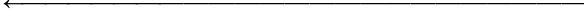
Fig. 2. a Unfiltered ground magnetometer H-component data from Nordli, Faroes and Wick compared with SABRE east-west velocity component data (positive east) averaged over a small region of the field of view, 64.6 ° to 64.8 ° N and 6 ° to 8 ° E. Dashed lines delineate the onset times of the two Pi2 pulsations at 17:36 UT and 17:49 UT; b the same time series data as a but for ground magnetometer D-component data compared with the SABRE north-south velocity component data